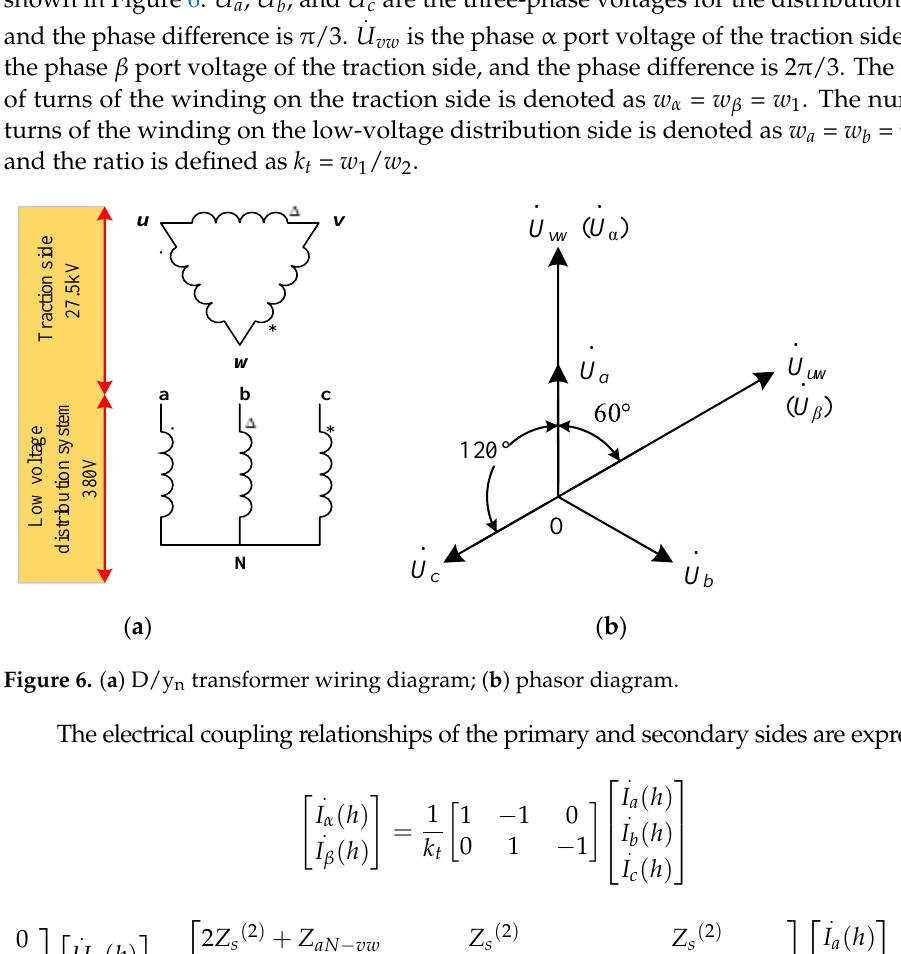
Figure 5. Harmonic propagation path on the high-voltage side of a V/v traction transformer. The low-voltage distribution system of the traction substation is supplied by the 27.5